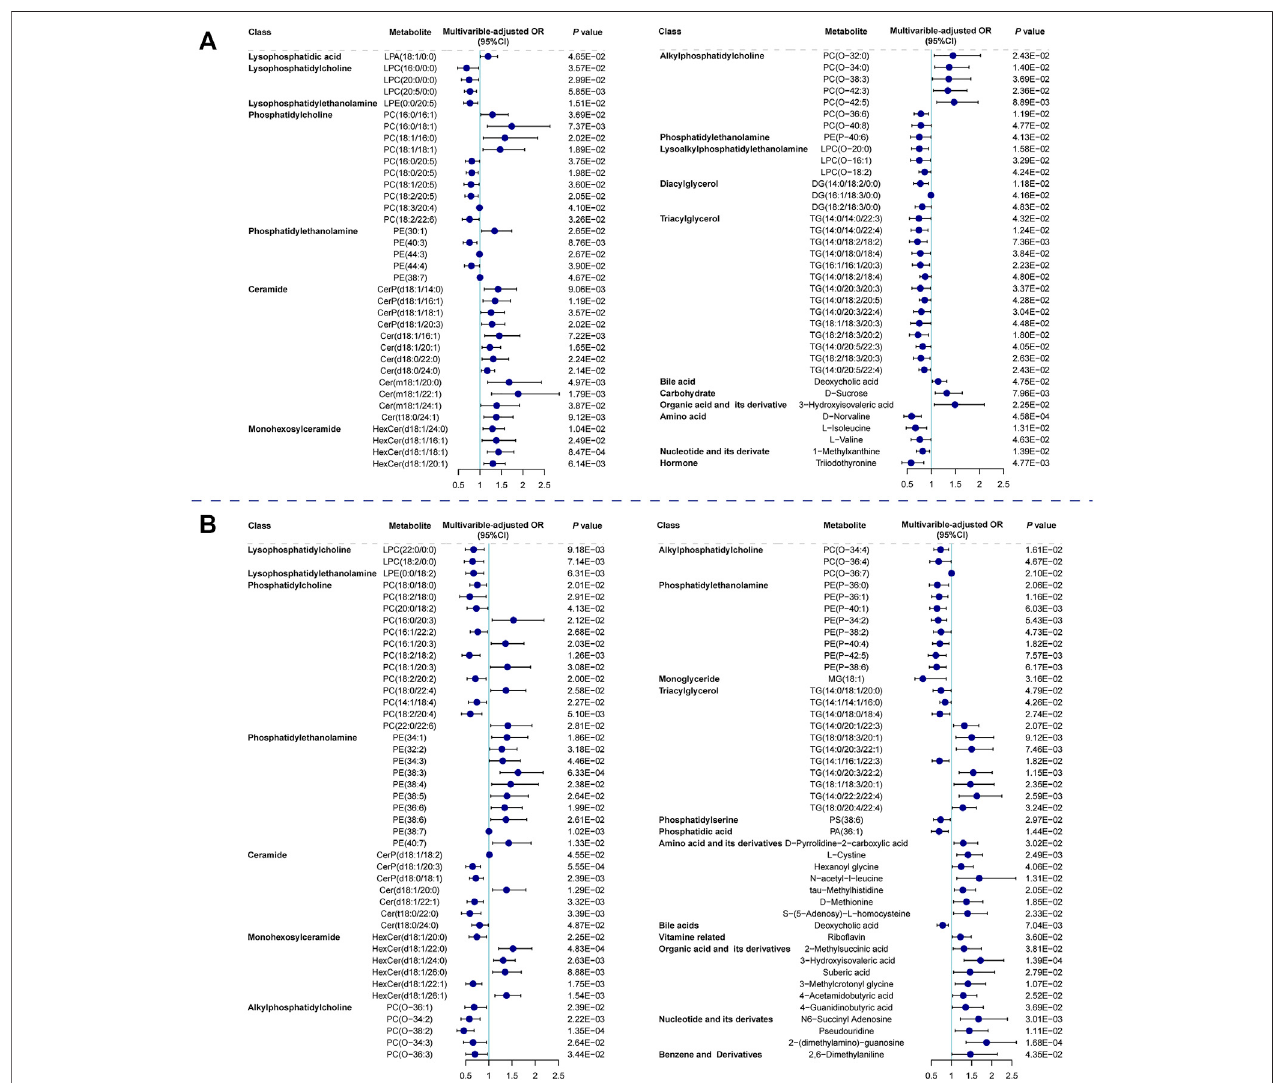
FIGURE 3 | Relationship between metabolic features against UA (vs. SCAD) and MI (vs. UA). Forest plot of odds ratios and 95% con fi dence intervals for logistic regression of individual metabolites/lipid species against (A) SCAD vs. UA ( p < 0.05) (B) UA vs. MI ( p < 0.05), adjusting for age, sex, hypertension, diabetes mellitus, smoking, LDLC, HDLC and TG. Cer, ceramide; CI, con fi dence interval; DG, diacylglycerol; HexCer, hexosylceramide; LPA, lysophosphatidic acid; LPC, lysophosphatidylcholine; LPC(O), lysoalkylphosphatidylethanolamine; LPE, lysophosphatidylethanolamine; MG, monoglyceride; OR, odds ratio; PA, phosphatidic acid; PC, phosphatidylcholine; PC(O), alkylphosphatidylcholine; PE, phosphatidylethanolamine; PE(P), phosphatidylethanolamine; PS, phosphatidylserine; other abbreviations as in Figures 1 , 2